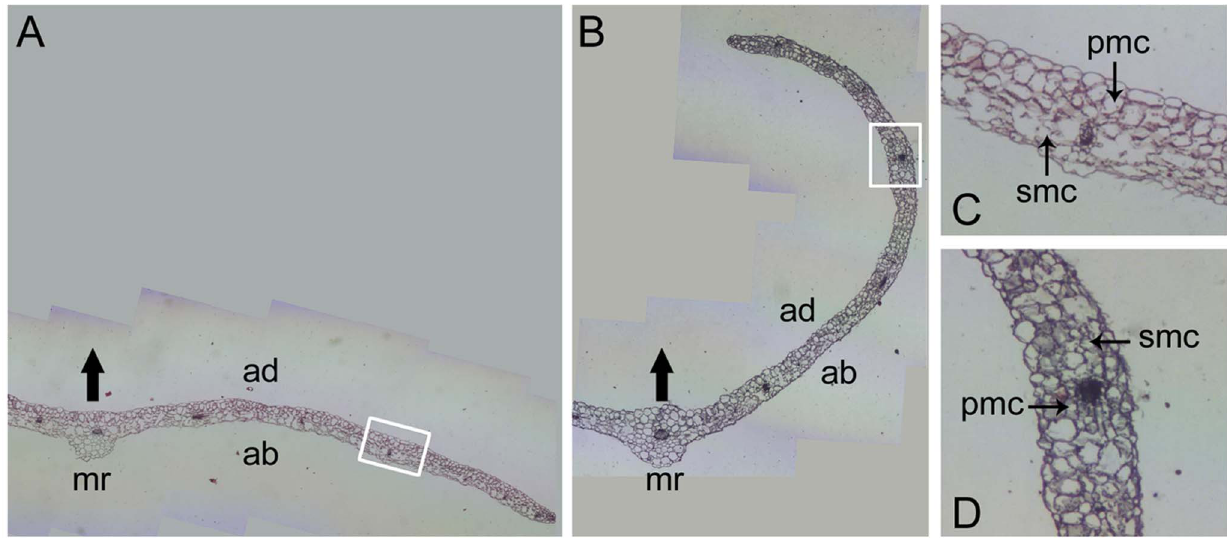
Figure 6. TaWRKY71-1 overexpression tightens spongy mesophyll tissue by the paraffin section assay. A, B: Transverse sections of middle part of the 6 th mature rosette leaves of VC (A) and OE3 (B) lines. C, D: The enlarged view of white pane-labeled section in panels A and B, respectively. VC, Vector control; OE3, an independent transgenic Arabidopsis lines overexpressing TaWRKY71-1 . Arrows in A and B show the adaxial direction. mr, main rib; ad, adaxial side; ab, abaxial side; pmc, palisade mesophyll cells; smc, spongy mesophyll cells.